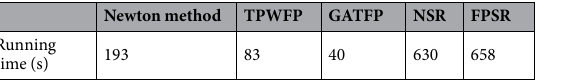
Table 1. Comparison of running time between state-of-the-arts methods and the proposed